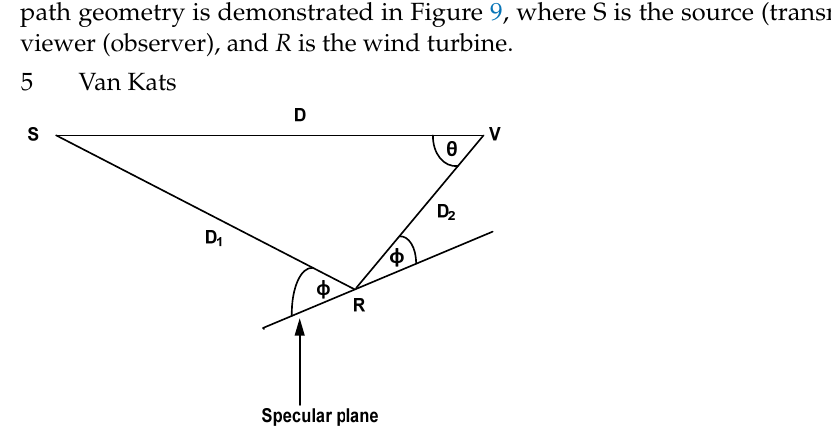
Figure 9. Adopted path geometry by BBC R.D [52] .